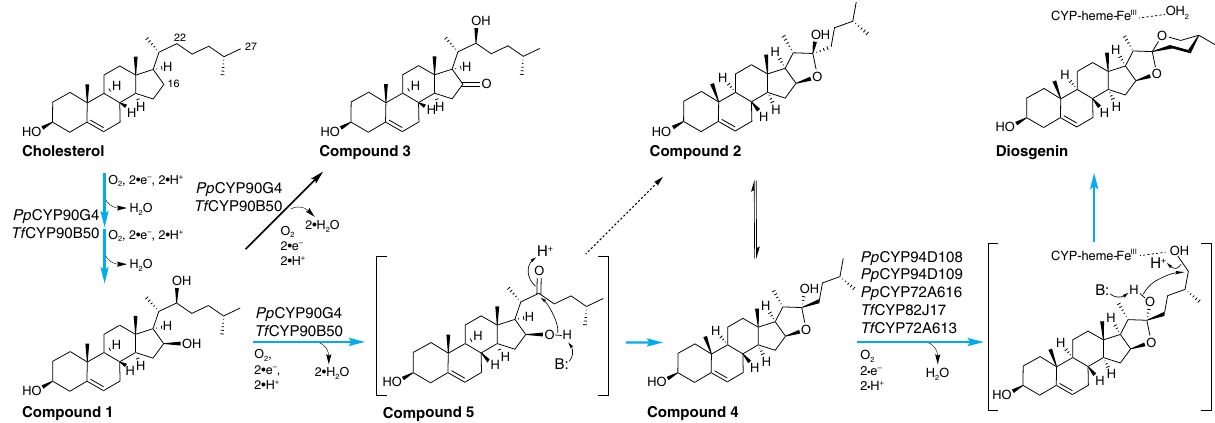
Fig. 4 The proposed catalytic sequence of CYP-mediated diosgenin biosynthesis from cholesterol. The on-pathway catalytic steps are colored in blue. The identity of the key intermediates were determined directly or inferred indirectly. Other possible mechanisms for the second cyclization step are presented in Supplementary